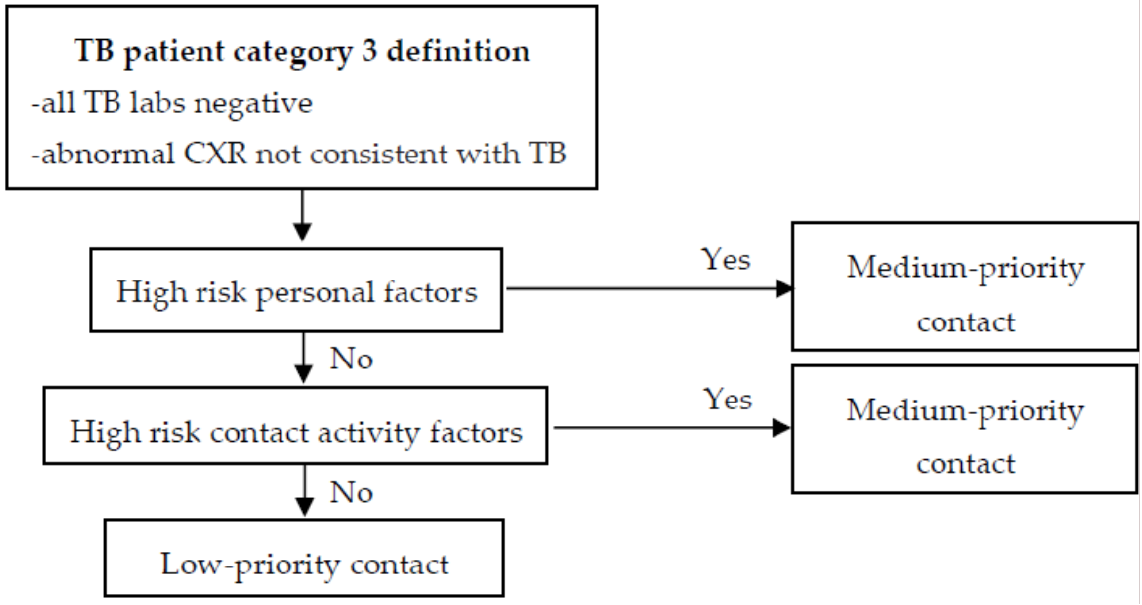
Figure 3. Prioritization of contacts exposed to TB Patient Category 3. (Source: OH&S Faculty of Medicine KKU